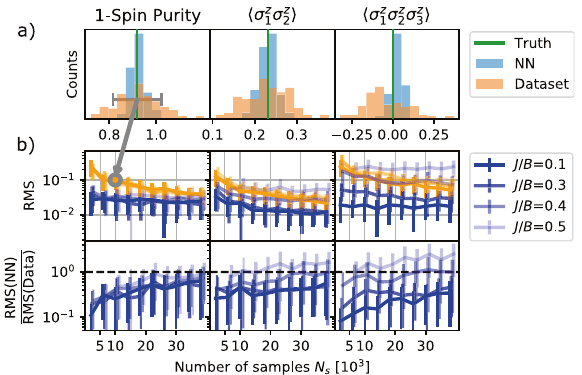
Fig. 3 Tomography of 2D Ising groundstates: NN vs plain data. Comparing the performance of the CCNN against the plain dataset in estimating local observables on a 4 × 4 Ising lattice with periodic boundaries. a Histogram of observable estimates from independent datasets and network initializations, with J / B = 0.3 and N s = 10 k . b RMS errors of observables for varying coupling strengths and dataset sizes, as well as comparisons of NN and plain dataset in terms of the quotient of their respective RMS errors. Error bars are standard deviations across multiple independent tomography datasets and neural network training runs with randomly initialized